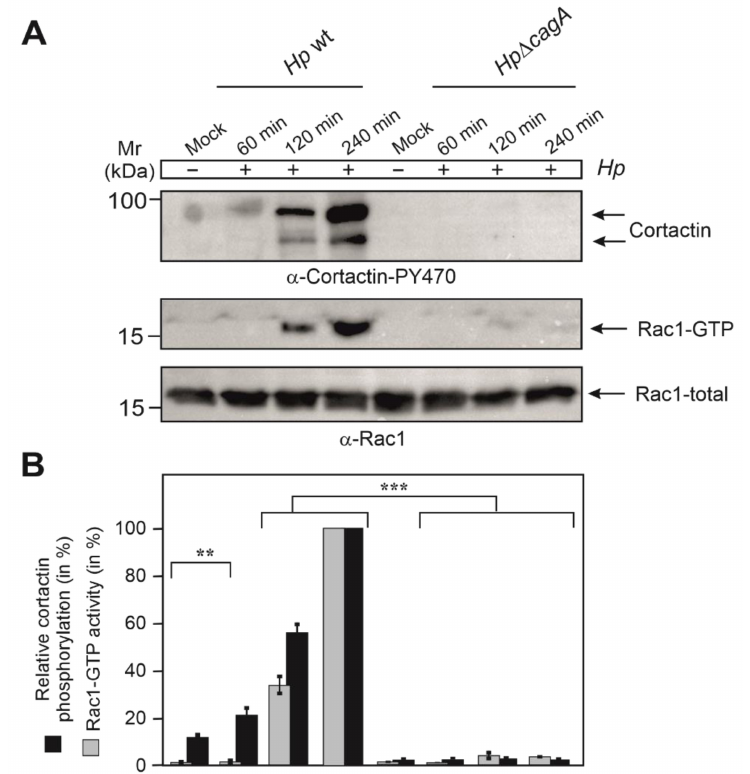
Figure 4. Cortactin phosphorylation at Y-470 temporally correlating with Rac1 activation during H. pylori infection. ( A ) AGS cells were infected with H. pylori wt or ∆ cagA mutant for different times, i.e., 60, 120 and 240 min, followed by probing with α -cortactin-PY-470 (top) or Rac1-GTP pulldown and α -Rac1 Western blot (middle). The α -Rac1 blot of total cell lysates served as loading control (bottom). ( B ) Quantification of band intensities on Western blots showing cortactin levels phosphorylated at Y-470 and relative Rac1-GTP activity. The results are from three independent experiments. p -values of ≤ 0.01 (**) and ≤ 0.001 (***) were considered as statistically significant. The results confirm that the induction of cortactin phosphorylation at Y-470 and activation of Rac1 display a temporal